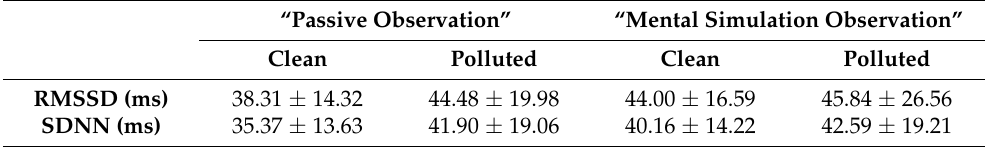
Table 1. The means ± standard deviation of the different parameters derived from the heart rate vari- ability for each condition. RMSSD = Root Mean Square of Successive R-R intervals; SDNN = Standard Deviation of all NN